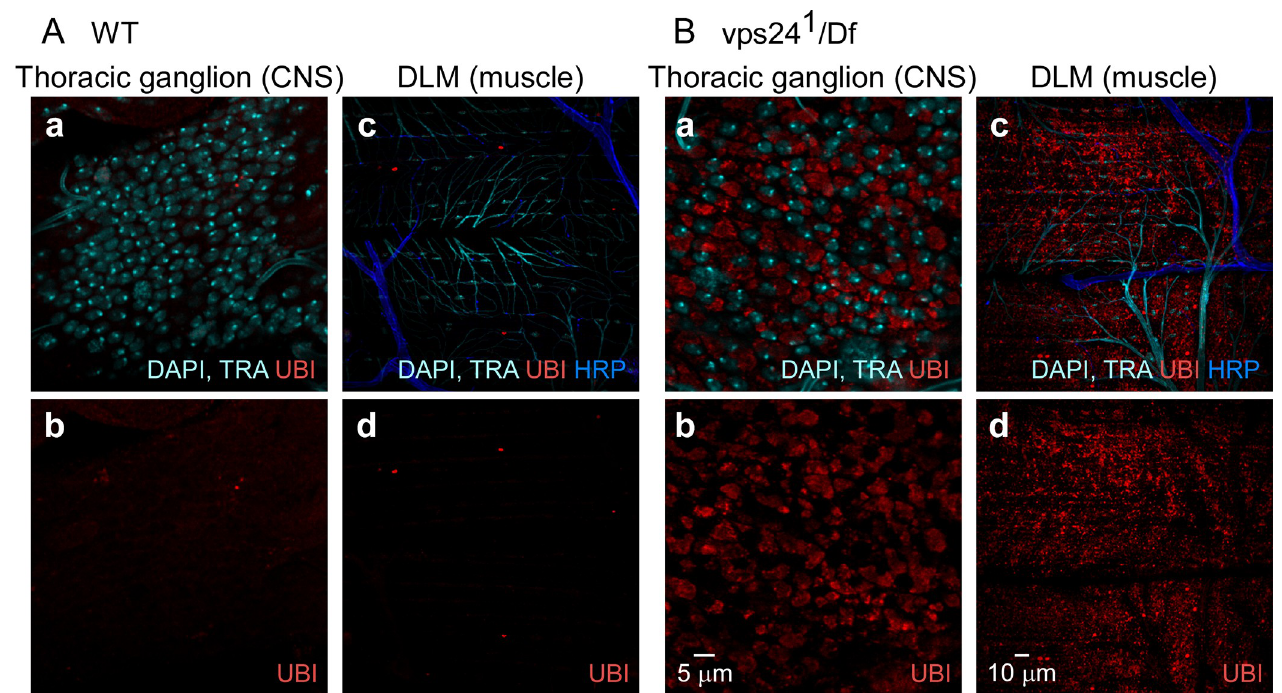
Fig 3. Ubiquitin-positive compartments accumulate in neurons and muscle of the vps24 mutant. Confocal immunofluorescence images from wild-type (WT) (A) or vps24 1 /Df(3R)Exel6140 (vps24 1 /Df) mutant flies (B) . Ubiquitin (UBI) staining indicates that the vps24 mutant exhibits a marked increase in ubiquitin-positive compartments in CNS (a, b) and muscle (c, d) with respect to WT. In contrast to neurons and muscle, ubiquitin positive structures are not prominent in glia of the vps24 mutant (see S4C and S4D Fig). DAPI labeling of nuclei and autofluorescence from trachea (TRA) appear in the same channel. Anti-HRP labels the neuronal plasma